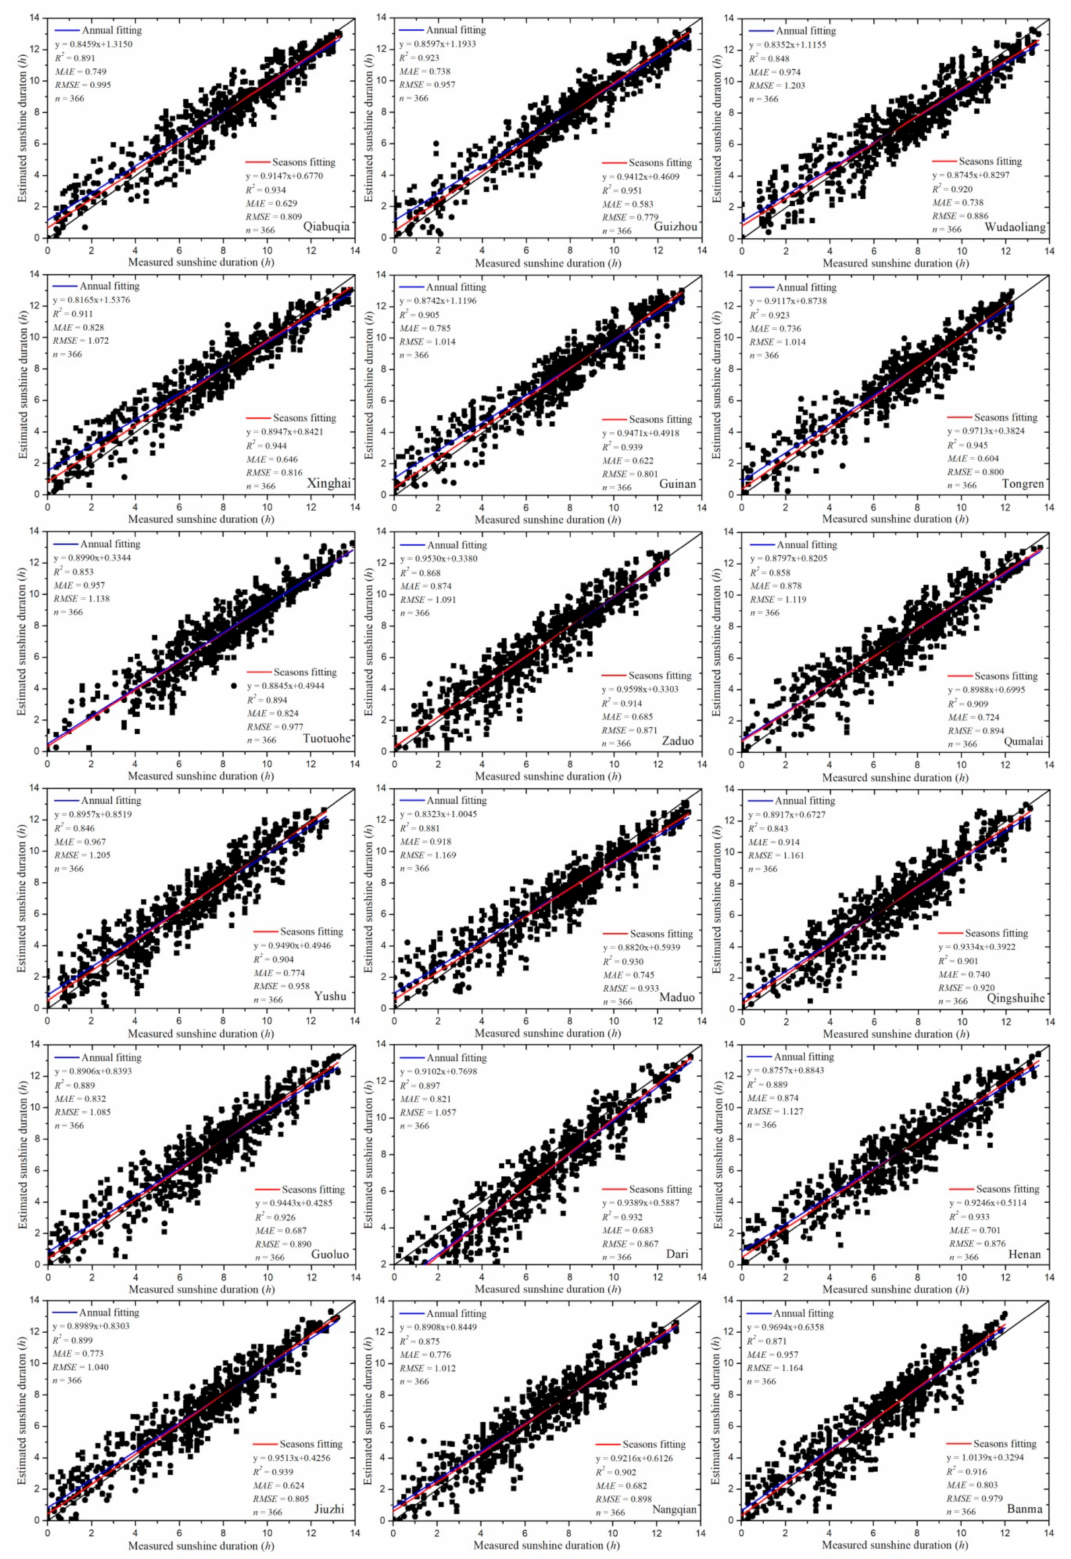
Figure 6. Validation of the measured sunshine duration and estimated sunshine duration for individual meteorological stations in the Three-River Headwaters region in